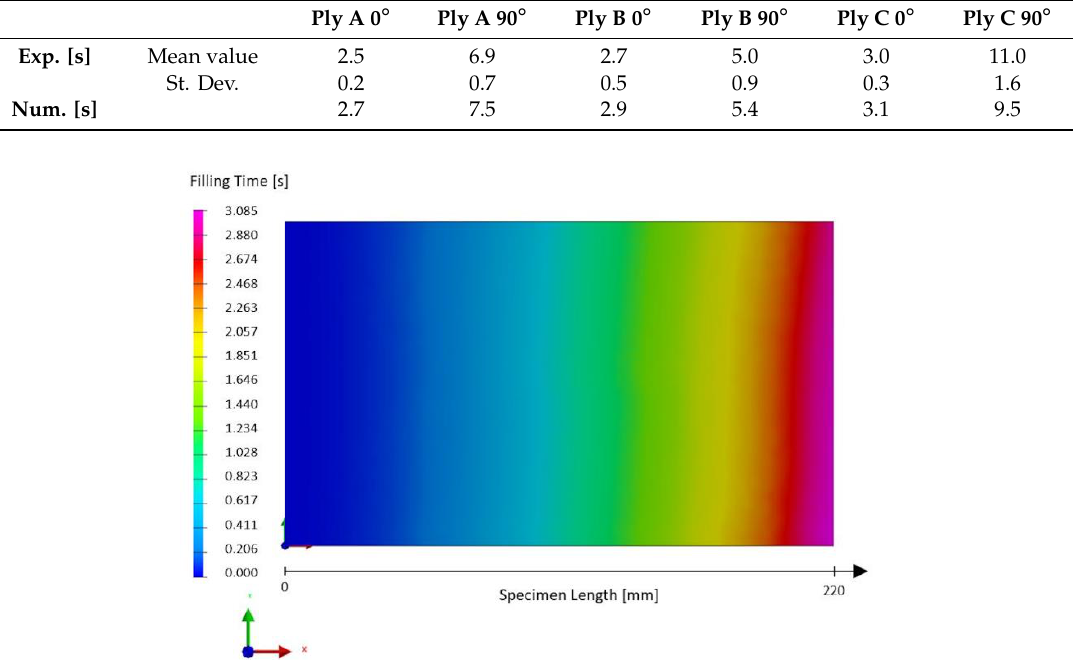
Figure 4. Contour map of the filling time computed numerically: example of case Ply C 0° (color scale in s).